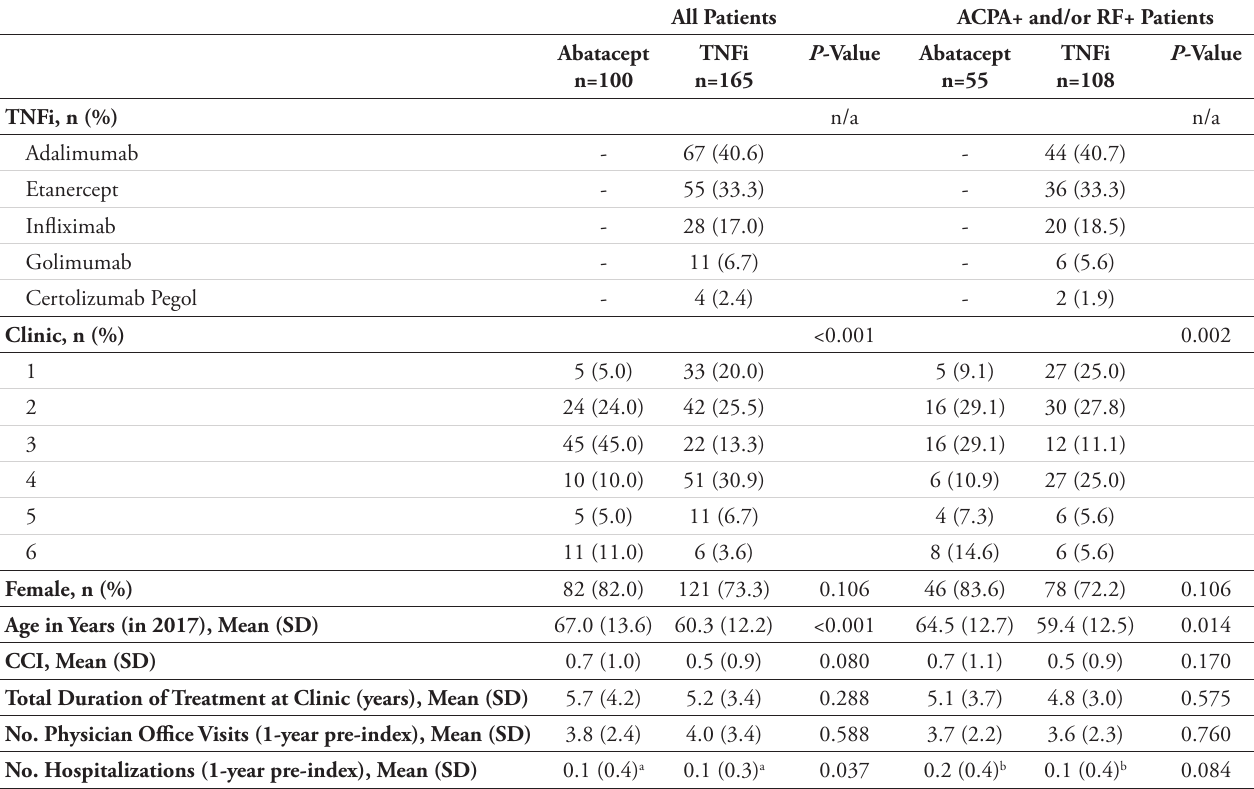
Table 1. Baseline Characteristics